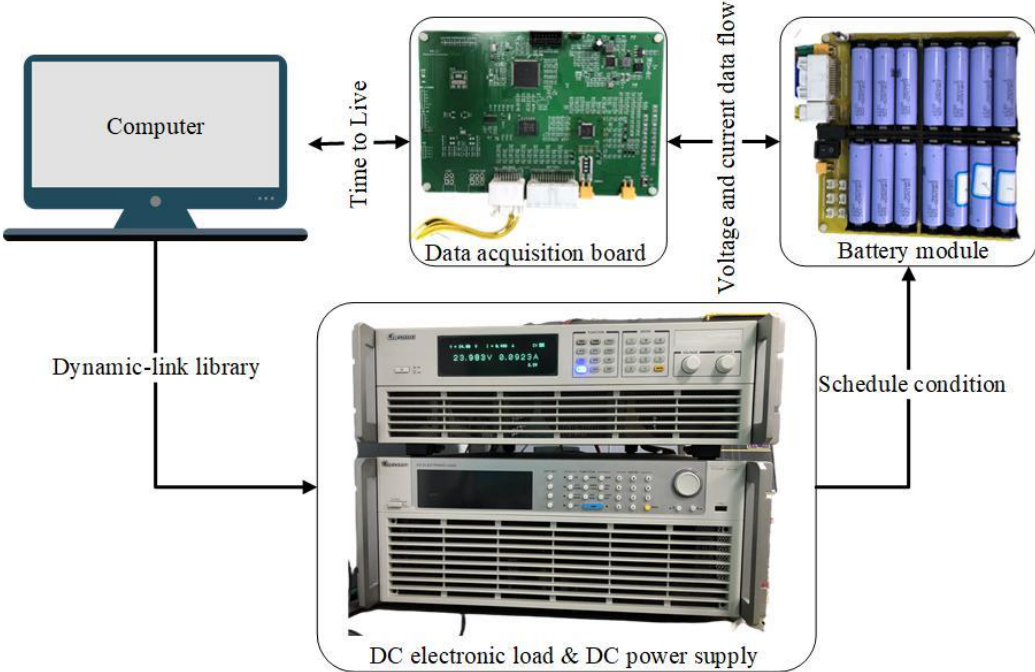
Figure 3. Outline of the hardware platform: online characterization of polarization voltage.